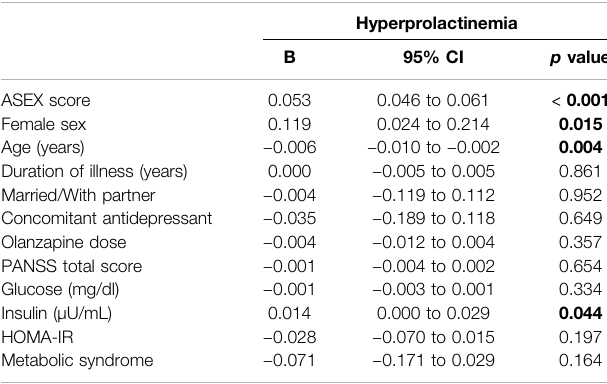
TABLE 2 | Multiple linear regression analysis with hyperprolactinemia as dependent